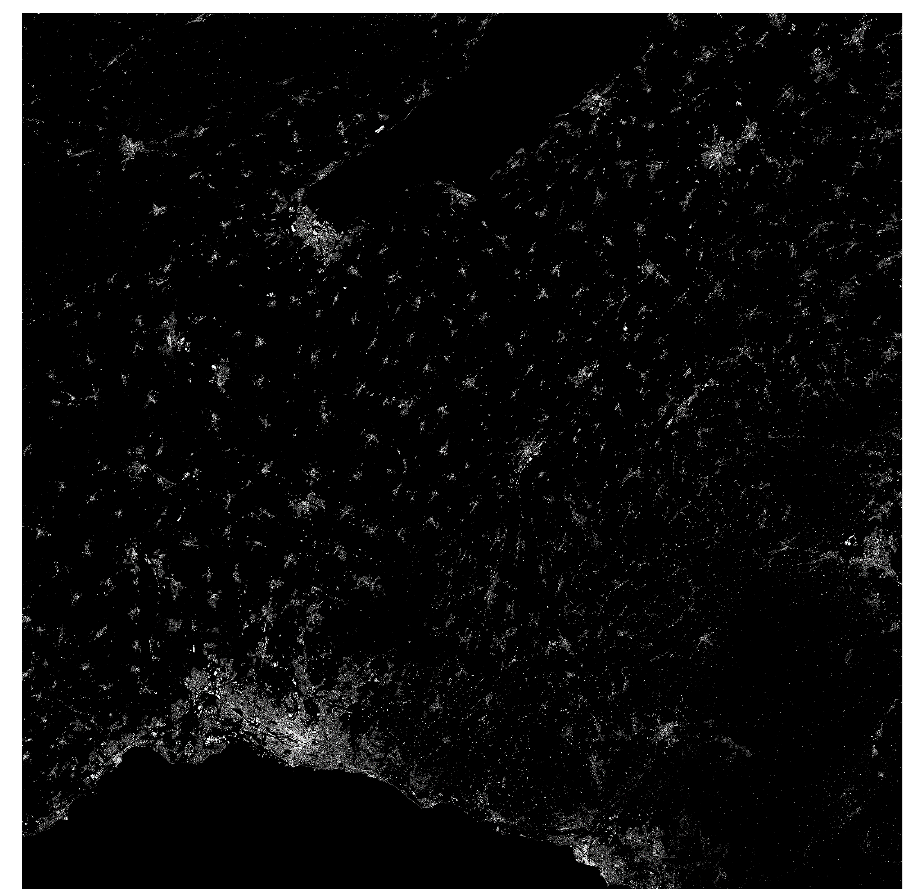
Figure 2. Canton of Vaud (2014), portion. 50x50 km: urban morphology: built (white). Source: Horizontal Metropolis, a radical project , Venice Architecture Biennale 2016,